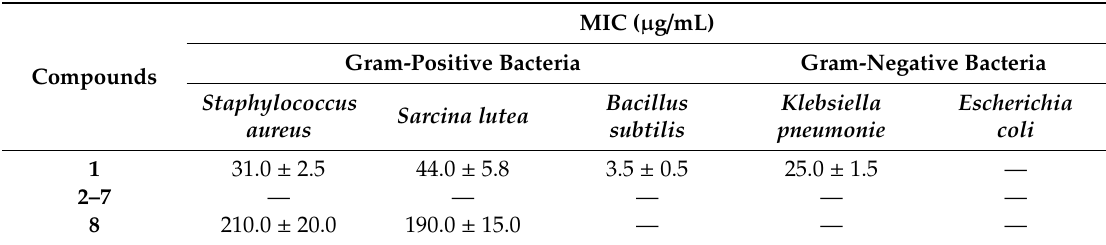
Table 4. The antibacterial activity of compounds 1-8.